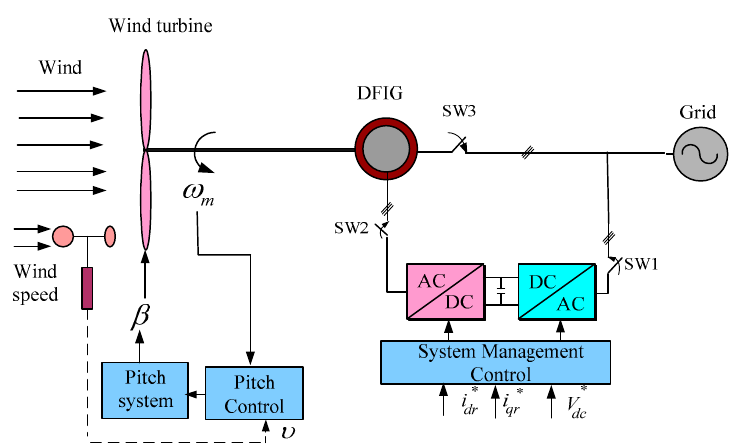
Figure 1. Basic configuration of the proposed wind-energy conversion system (WECS).